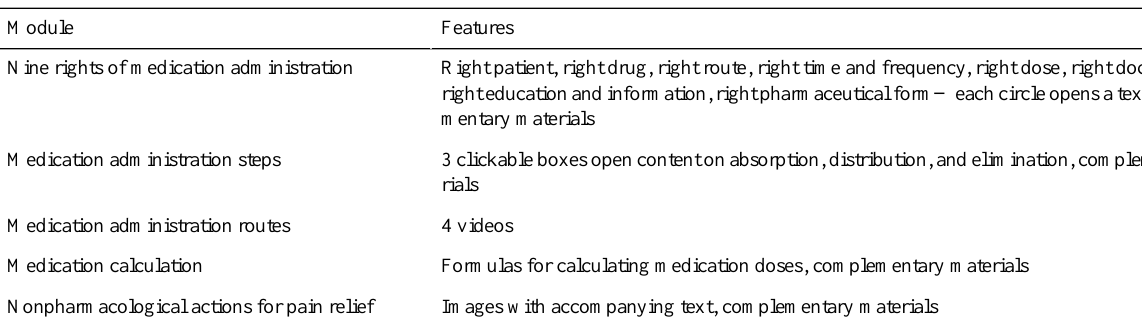
Table 1. Virtual learning environment